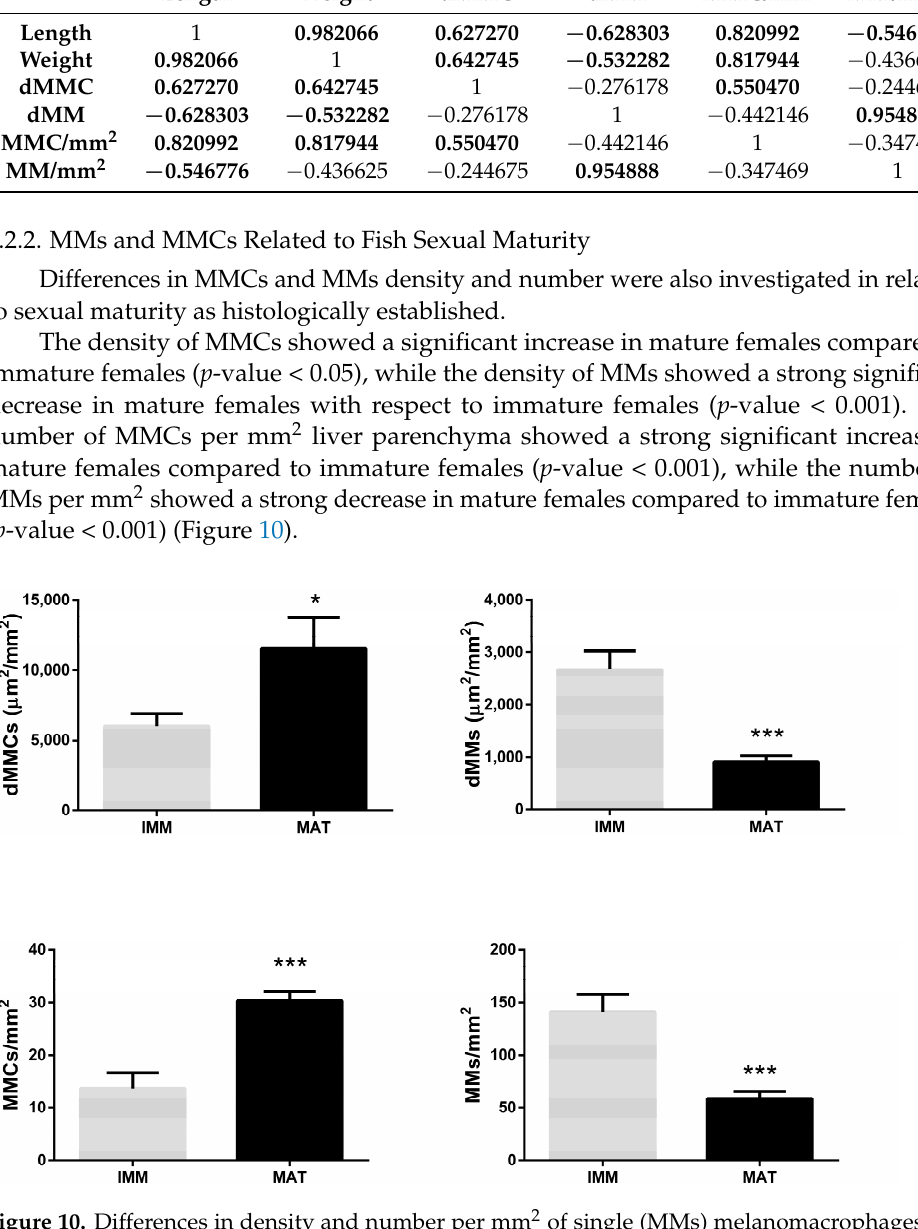
Figure 10. Differences in density and number per mm 2 of single (MMs) melanomacrophages and centers (MMCs) between livers of immature (IMM; n = 22) and mature (MAT; n = 28) females. Asterisk (*) indicates significant statistical difference (* = p -value < 0.05, *** = p -value < 0.001).